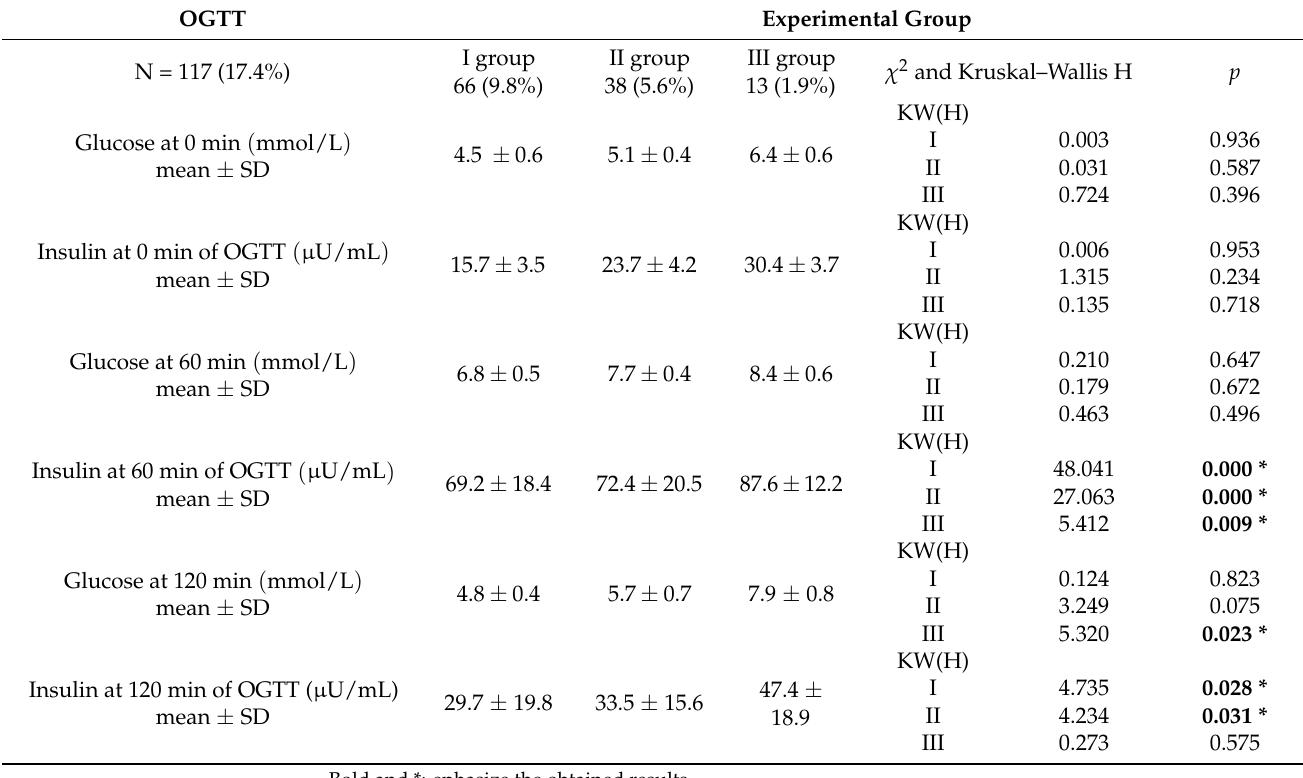
Table 1. Results of the OGTT test of the experimental group.